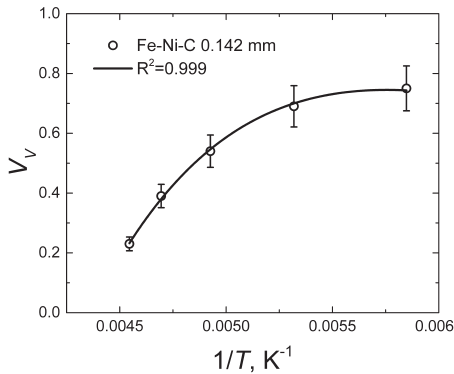
Fig. 3 – Volume fraction of martensite plates per unit of volume against transformation temperature. Fe-31wt%Ni-0.02wt%C alloy 30 with a mean intercept length of austenite grains equal to 0.142 mm. Solid line corresponds to the model developed here: equation 9. Error bars corresponding to an estimated relative error of ±10% were added to the plot.